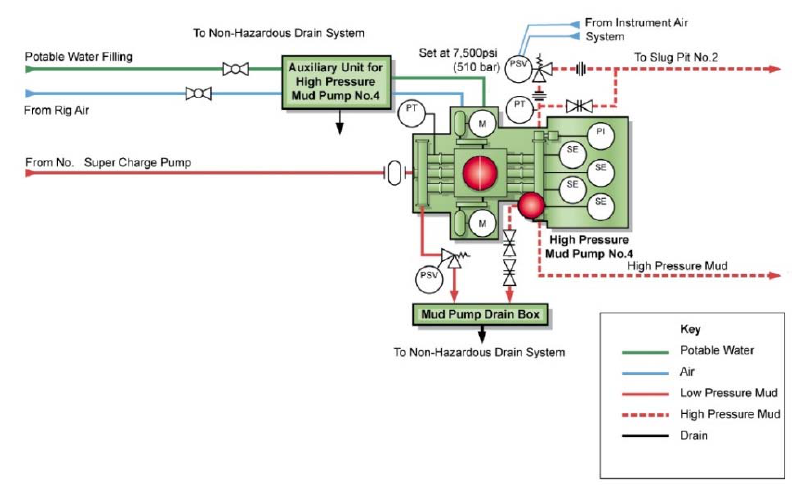
Figure 2. The system of a mud pump installed on a drillship [4].